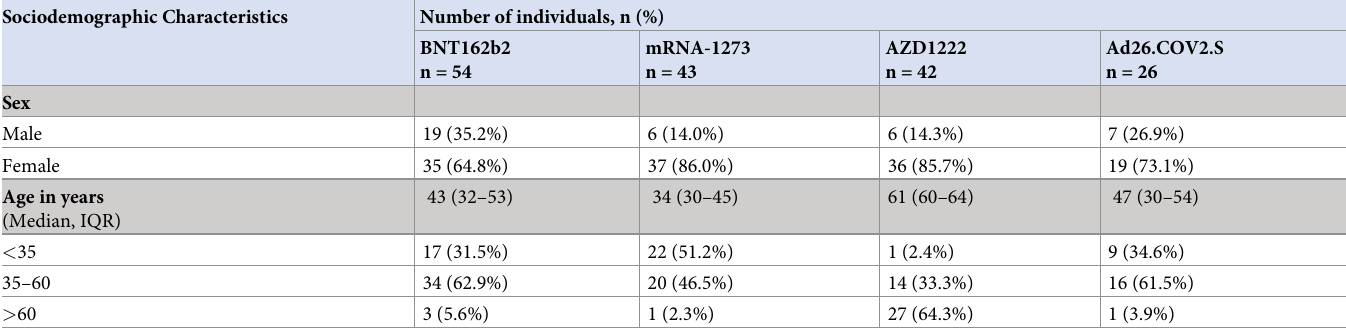
Table 1. Sociodemographic characteristics. Sociodemographic